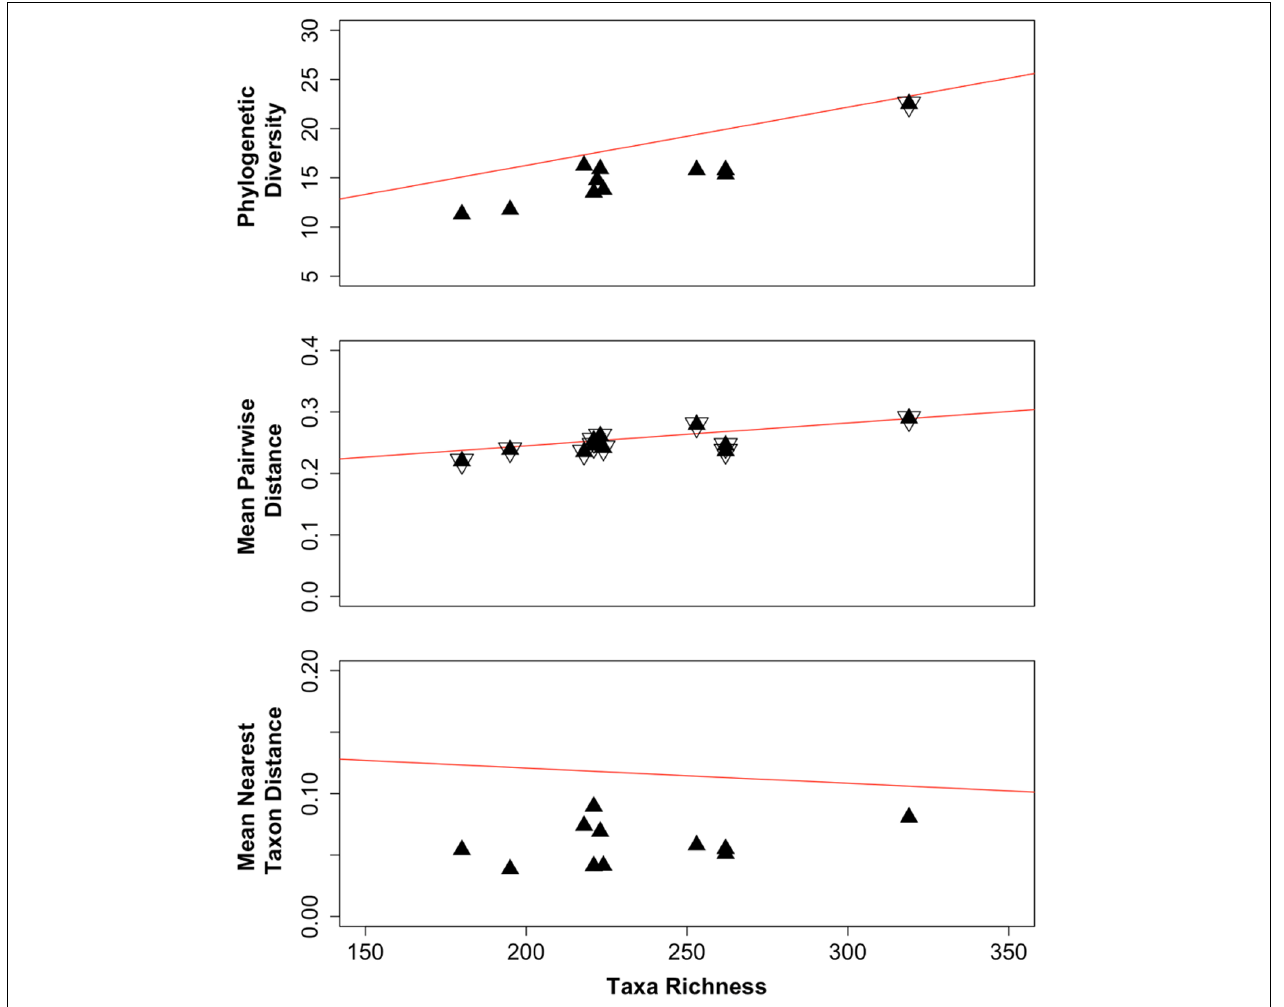
FIGURE 4 | Observed values (black triangles) for phylogenetic diversity (PD, top panel), mean pairwise distance (MPD, middle panel) and mean nearest taxon distance (MNTD, bottom panel) of assemblages relative to the taxa richness. The regression line is shown for the corresponding null mean values (red lines). Assemblages marked with an open triangle indicate the observed values were within two standard deviations of the null mean values.